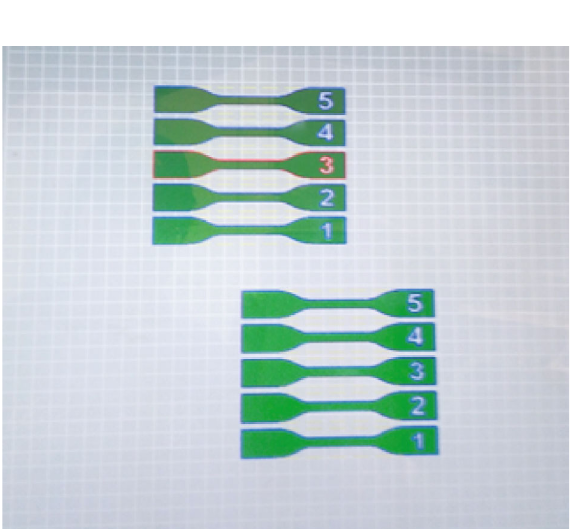
Figure 2: Orientation of the labelled test specimens (ASTM D